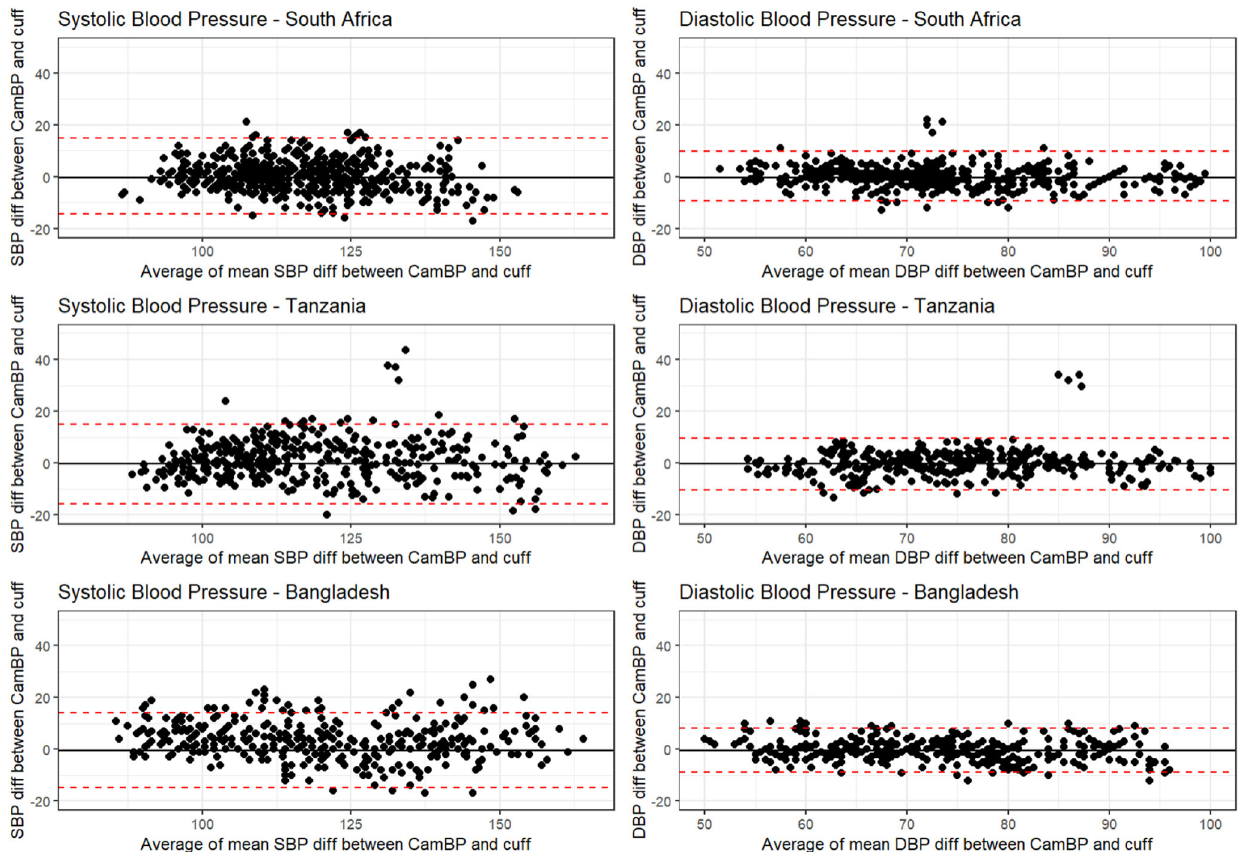
Fig. 3 Bland-Altman Plots across